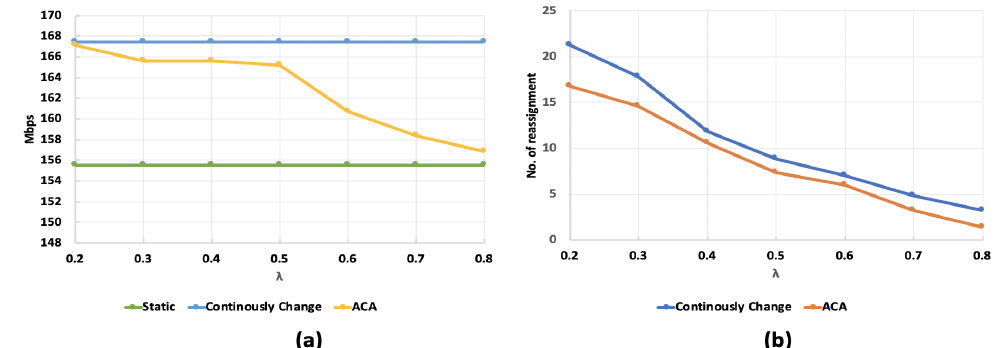
Figure 7. The network topology 2 results, the number of channel reassignments, and the overall throughput with the maximum three NICs, ( a ) throughput comparisons and ( b ) channel reassignment